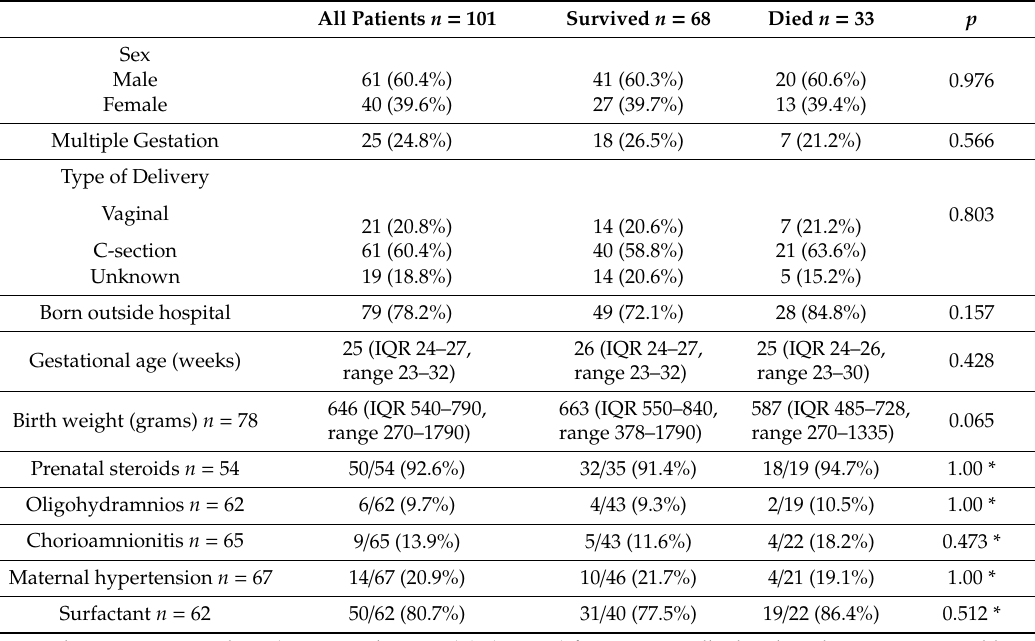
Table 1. Pregnancy and birth